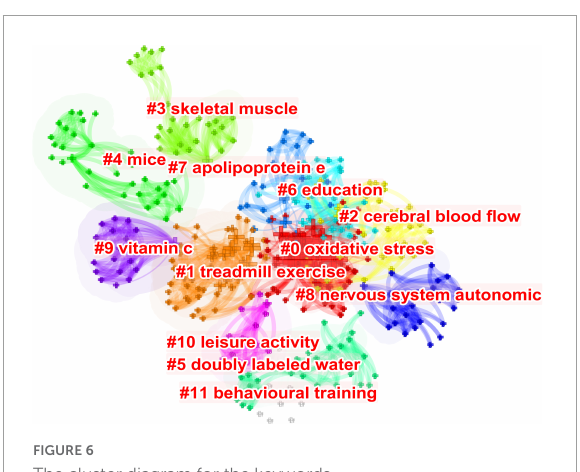
FIGURE6 The cluster diagram for the